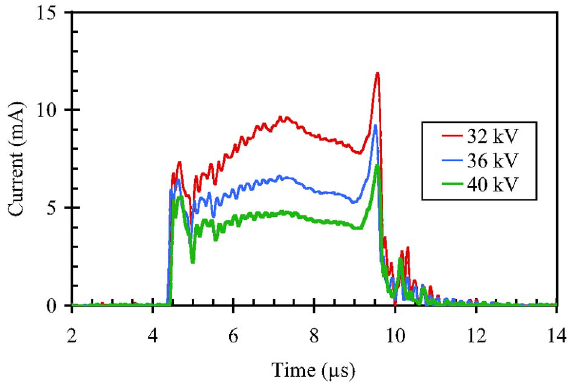
FIG. 11. (Color) Electron emission current from the GESD , listed by the legend target versus time for three values of V QI10 in the same order as the plots. (The normal operating point for other data in this paper is 40 kV.) The beam hits the target at (cid:4) (cid:4) 78 : 25 (cid:1) . The Child-Langmuir current limit is 0.8 mA. The FIG. 12. (Color) Electron emission current as a function of spikes at the head and tail of the beam are a result of a angle of incidence measured from normal for grid bias of (cid:6) 50 V (red +), (cid:6) 100 V (green *), and (cid:6) 150 V (blue (cid:9) ). The mismatch of these parts of the beam, resulting in the head and tail having a smaller envelope than does the flattop of the suppressor was biased to (cid:10) 50 V , the target to (cid:10) 40 V , and the beam, at the GESD axial position. catcher to (cid:10) 25 V